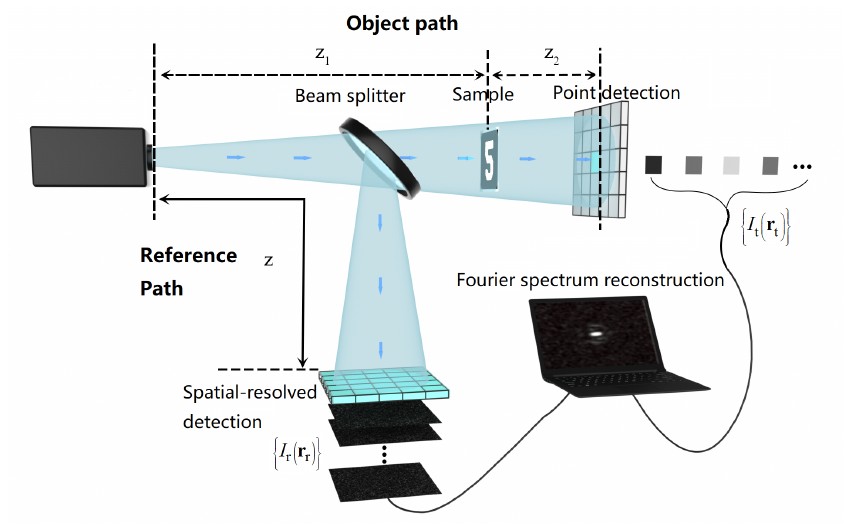
Figure 4. Schematic diagram of the diffraction GI. In the reference path, the distance from the source to the detector array is z . In the object path, the light passes through the imaging object which is z 1 away from the source and then propagates z 2 to be recorded by a point-like detector located at r t (the point-like detection is represented by a painted grid here that denotes only the intensity of one grid is recorded). The Fourier-transform diffraction spectral of the sample can be obtained via the second-order correlation when z = z 1 + z 2